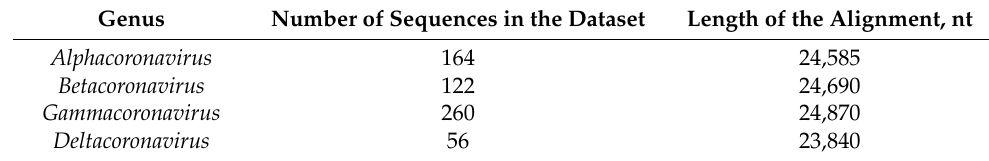
Table 1. Datasets used for recombination analysis. Detailed sequence data provided in Table S1. Genus Number of Sequences in the Dataset Length of the Alignment, nt Alphacoronavirus 164 24,585 Betacoronavirus 122